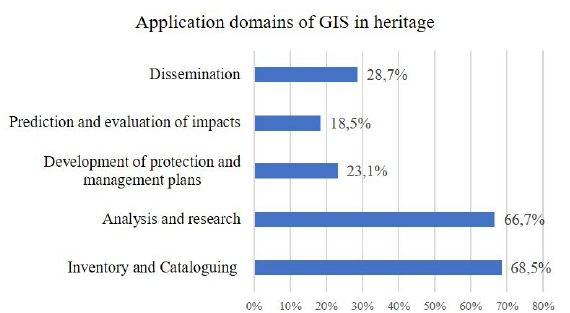
Figure 4: Graph of the application domains of GIS in